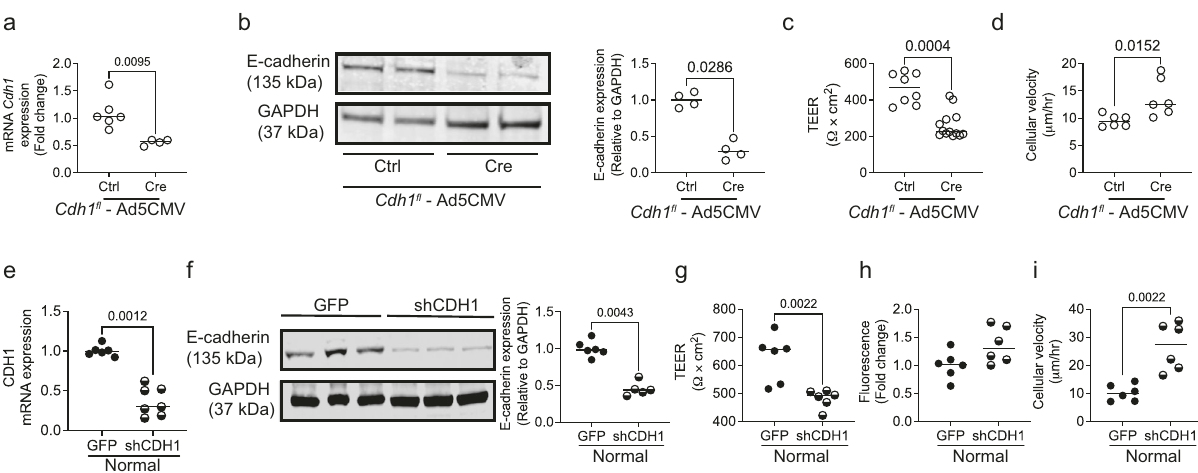
Fig. 6 Knockdown of E-cadherin contributes to epithelial dysfunction. To knock down E-cadherin in airways, mice tracheal epithelial cells (mTECs) from Cdh1 fl / fl mice cultured at the air-liquid interface (ALI) were transfected with Ad5CMVCre-eGFP (Cre) at 2 × 10 9 pfu and these were compared to Ad- 5CMVeGFP (Ctrl). mTECs transfected with Cre show reduction in E-cadherin as assessed by a mRNA expression of Cdh1 (encodes for E-cadherin), and b western blotting (representative image – left panel, and quanti fi cation – right panel). c Epithelial resistance was decreased, and d cellular velocity was increased in mTECs with E-cadherin knockdown. Data is expressed as median bars and generated of cells derived from 12 mice, 4 to 12 inserts. Normal human bronchial epithelial cells at ALI (normal controls) were transfected with Ad-GFP-U6-h-CFL1-shRNA (shCDH1) at 1.5 × 10 9 pfu to knock down E-cadherin and these were compared to control adenovirus (Ad-GFP-U6-shRNA, GFP). Normal control cells transfected with shCDH1 show reduced e mRNA of CDH1 (encodes for E-cadherin) and f protein expression of E-cadherin (representative blot — left panel, and quanti fi ed blot — right panel). Assessment of the epithelial barrier function indicates that g monolayer resistance was decreased, h a trend towards increased permeability, and i cellular velocity was increased in control cells with knockdown of E-cadherin. Data is expressed as median bars and representative of 5 to 10 inserts per condition. Mann-Whitney test was performed and P < 0.05 was considered statistically signi fi